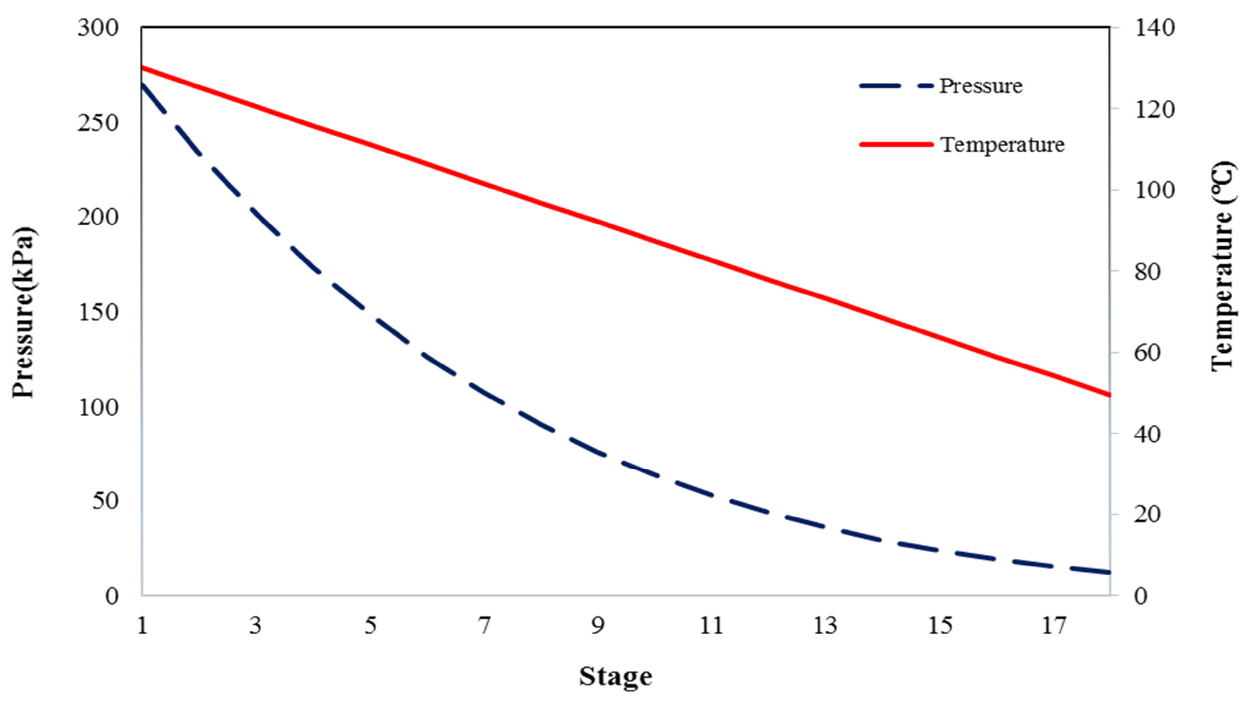
Figure 4. Variations of temperature and pressure in each stage .